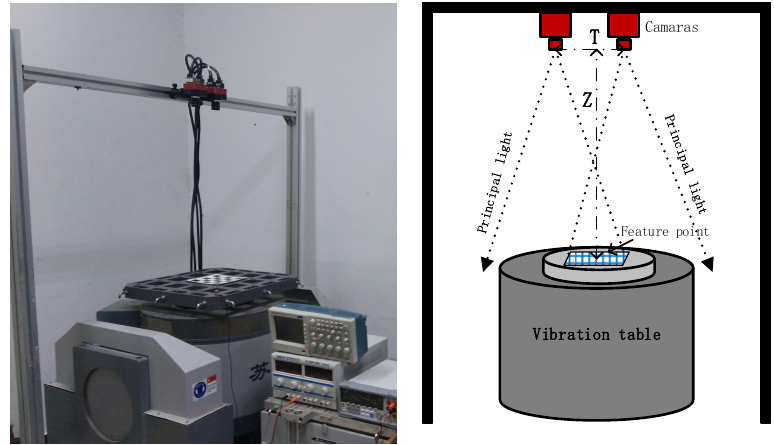
Figure 2. Calibration setup based on vibration table.